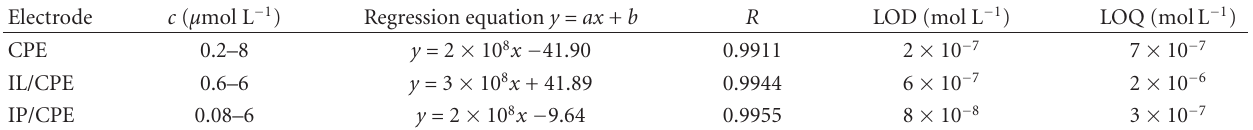
Table 3: Parameters of calibration regression straight lines and limits of detection (LOD) and quantification (LOQ) of rutin on the tested carbon paste electrodes, DPV measurement.